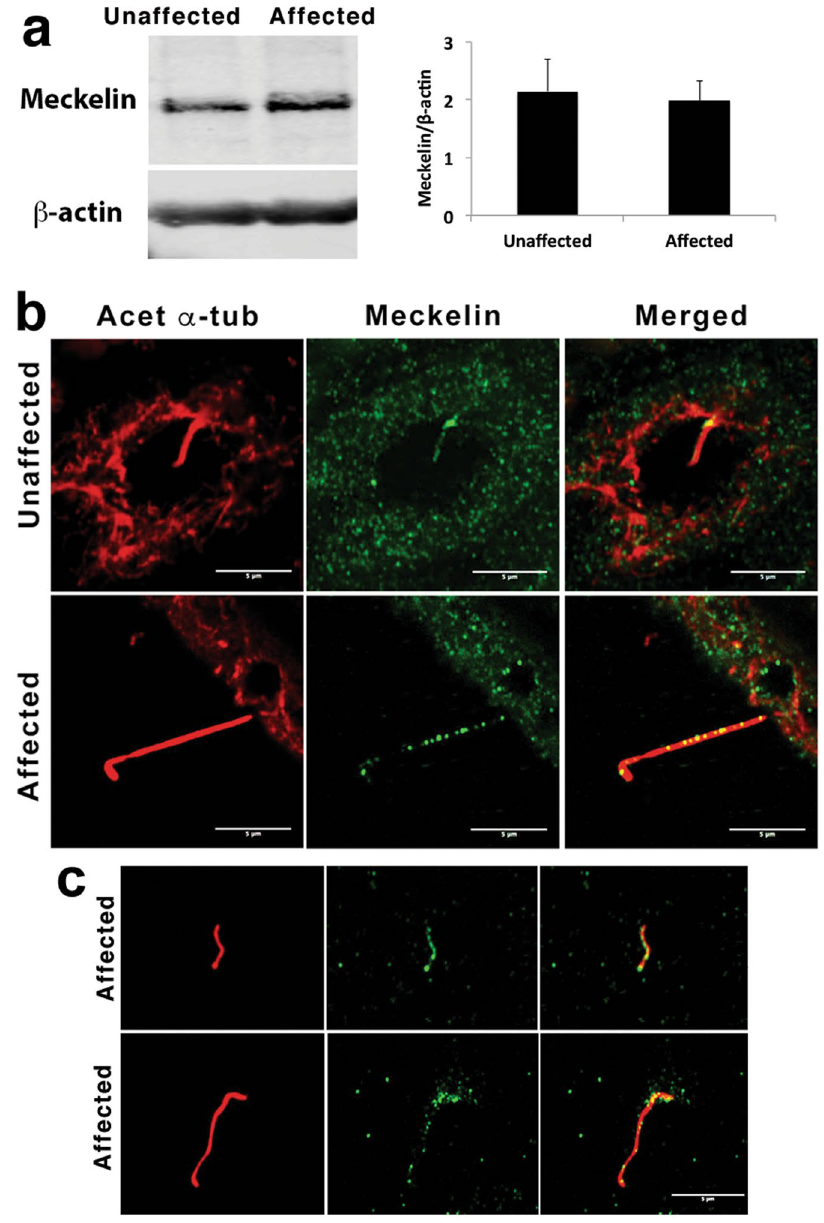
Figure 6. Meckelin expression in unaffected and affected lamb kidney epithelial cells and primary cilia. ( a , left) Immunoblot showing expression of meckelin (~100 KDa) in cultured epithelial cells from an unaffected lamb kidney, and an affected lamb kidney. β -actin indicates equivalent protein loading in each lane. ( a , right) Quantification of the meckelin band in the immunoblot, normalised to the loading control, shows no significant difference in relative protein expression. ( b ) Confocal maximum projection of acetylated α -tubulin (red) and meckelin (green) labelling in sections from unaffected and affected kidneys. In unaffected kidneys, meckelin was present within the cytoplasm of the epithelial cells and strongly localised to the base of the cilium. In contrast, meckelin was distributed along the length of the ciliary axonemes of affected cyst-lining cells. Meckelin distribution within the cytoplasm of cyst lining cells was similar to observations in unaffected epithelia ( c ) Acetylated α -tubulin (red) and meckelin (green) labelling on putative ciliary fragments located in the cyst lumen of affected kidneys (yellow indicates co-localisation in the merged image). Numerous smaller particles contained in the cyst luminal contents were also labeled with meckelin, but were not labeled with acetylated α -tubulin. Scale bars = 5 μ